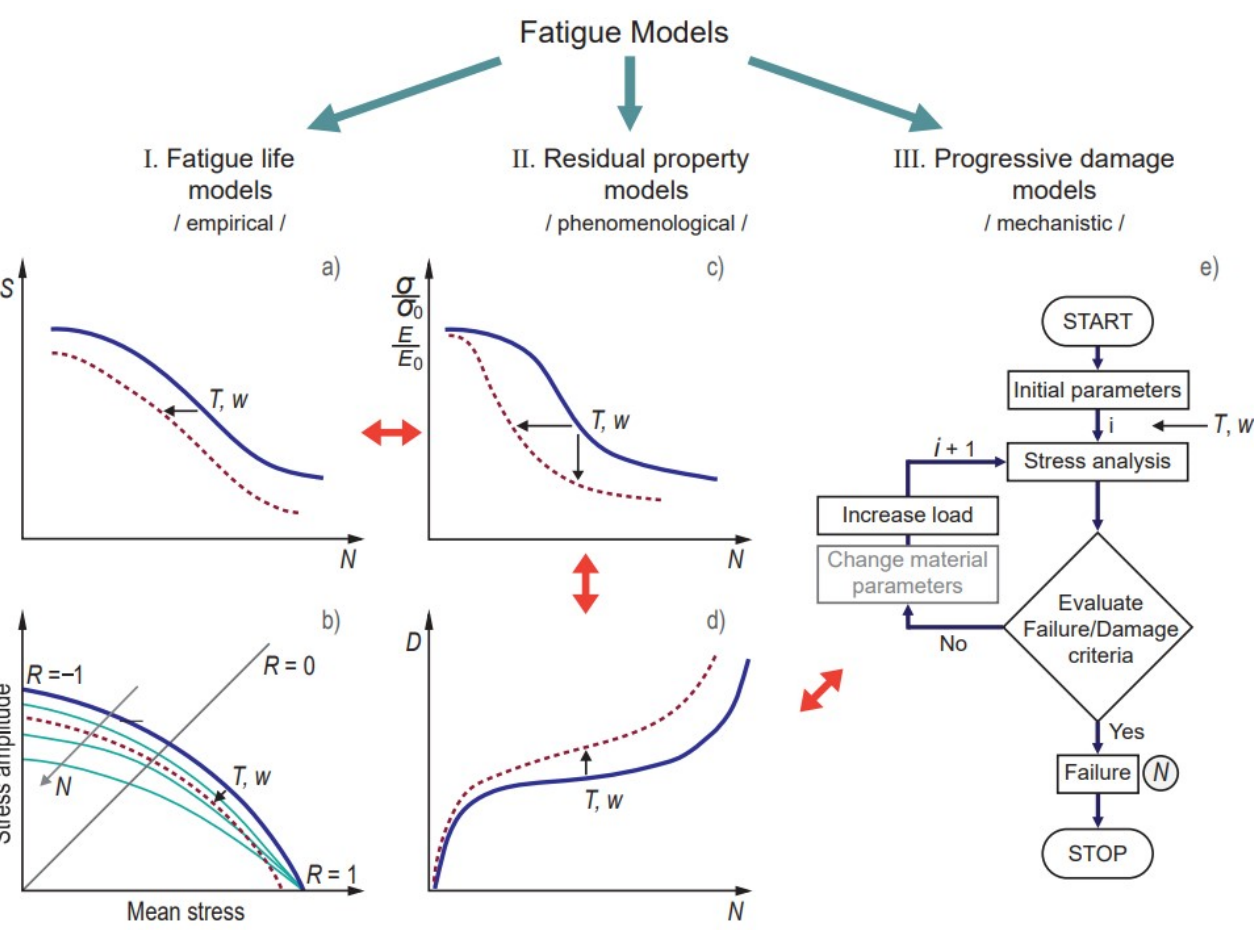
Figure 12. Classification of fatigue models and the principal ways for predicting the environmental impact (e.g., temperature T and water content w ). Representative methods for fatigue analysis: ( a ) S–N curve; ( b ) constant life diagram; ( c ) residual strength/stiffness dependence on the number of cycles; ( d ) damage function; ( e ) flowchart of progressive damage analysis.